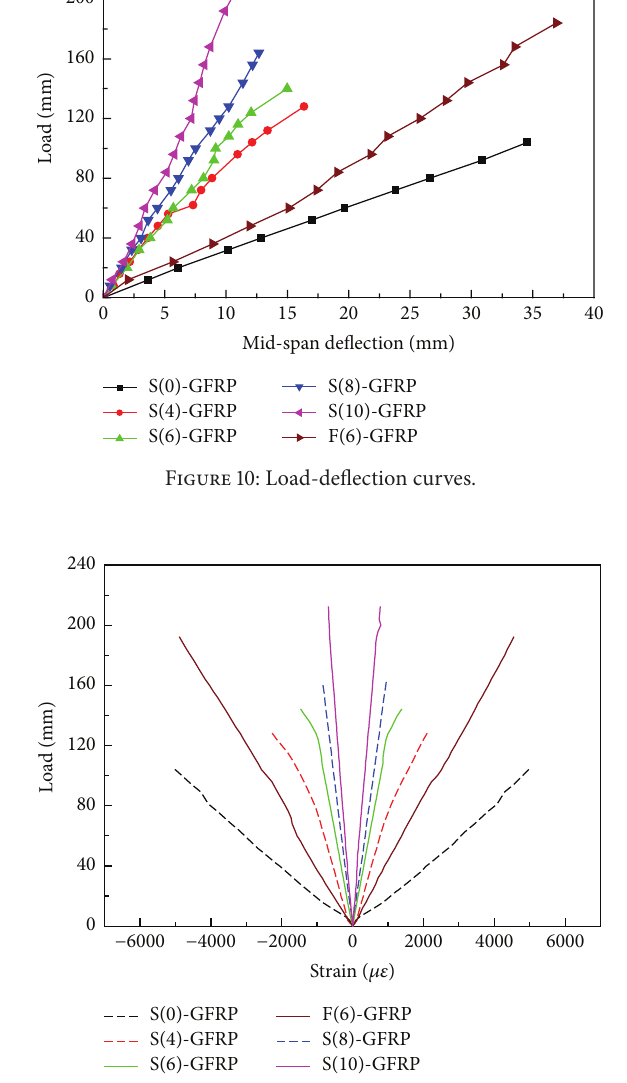
Figure 11: Mid-span load-strain curves.